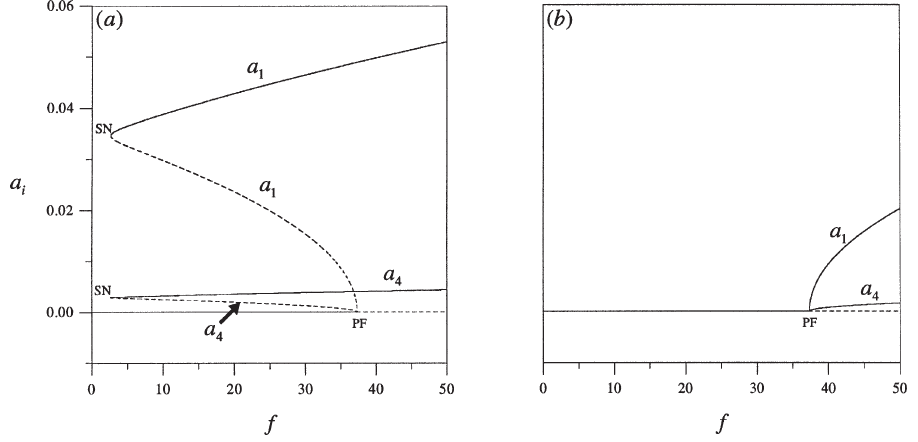
Fig. 5. Amplitude-response curves for a combination parametric resonance of the additive type involving modes 1 and 4 when (cid:22) 1 = 0 : 0137 and (cid:22) 4 = 0 : 0573. In part (a), (cid:27) = (cid:0) 1 and in part (b), (cid:27) = 1. Solid lines (—) denote stable fixed points and dashed lines (– – –) denote unstable fixed